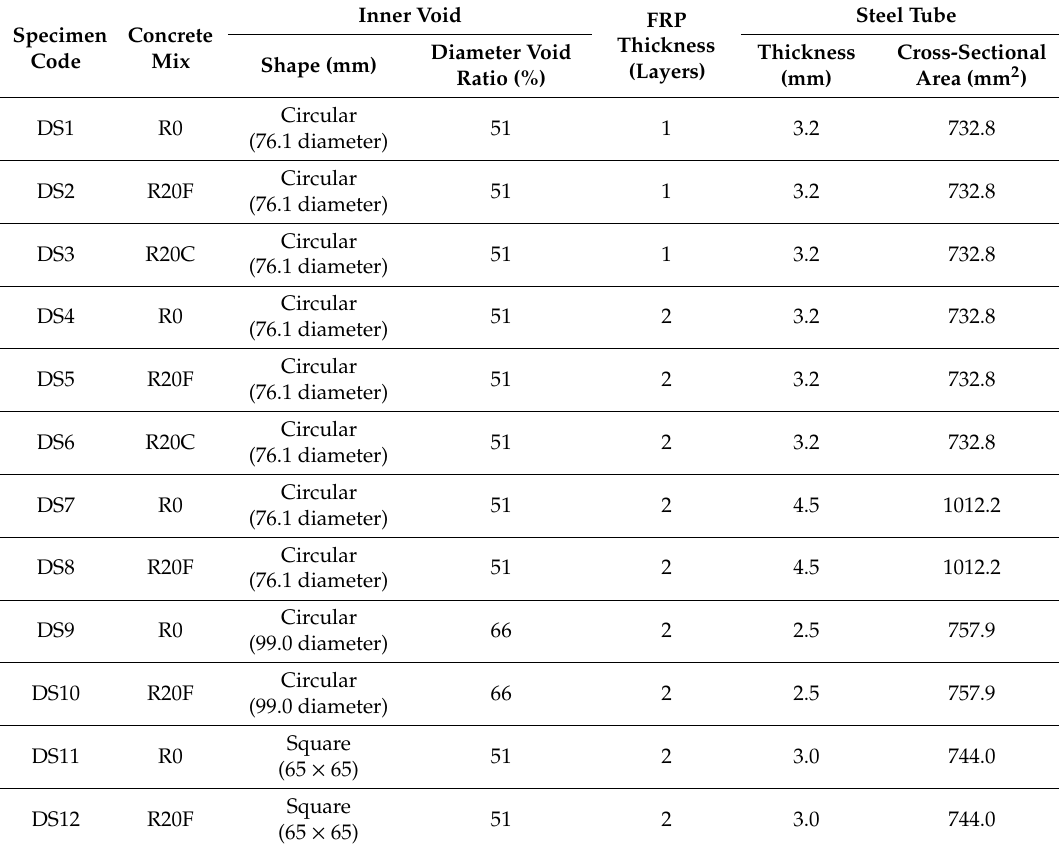
Table 2. Details of specimens tested in this